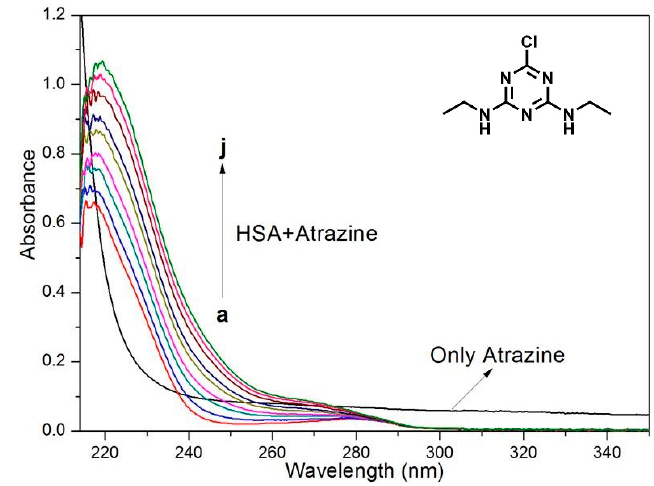
Figure 3. Absorption spectra of HSA (3.0 × 10 − 6 mol/L) upon the addition of ATR. The arrows show the increase in the ATR concentration. The ATR concentrations were 0.3, 0.6, 0.9, 1.2, 1.5, 1.8, 2.1 and 2.4 × 10 − 6 mol/L, respectively.